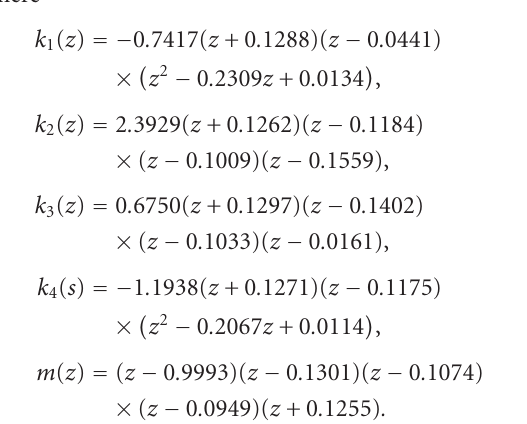
Figure 5: Sheet terminal surface temperatures (1st simulation).